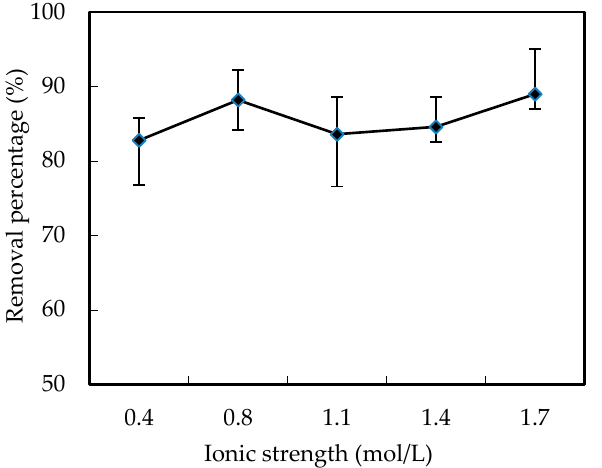
Figure 3. Effects of the ion strength in the feeding cell on the removal percentage of W (VI).